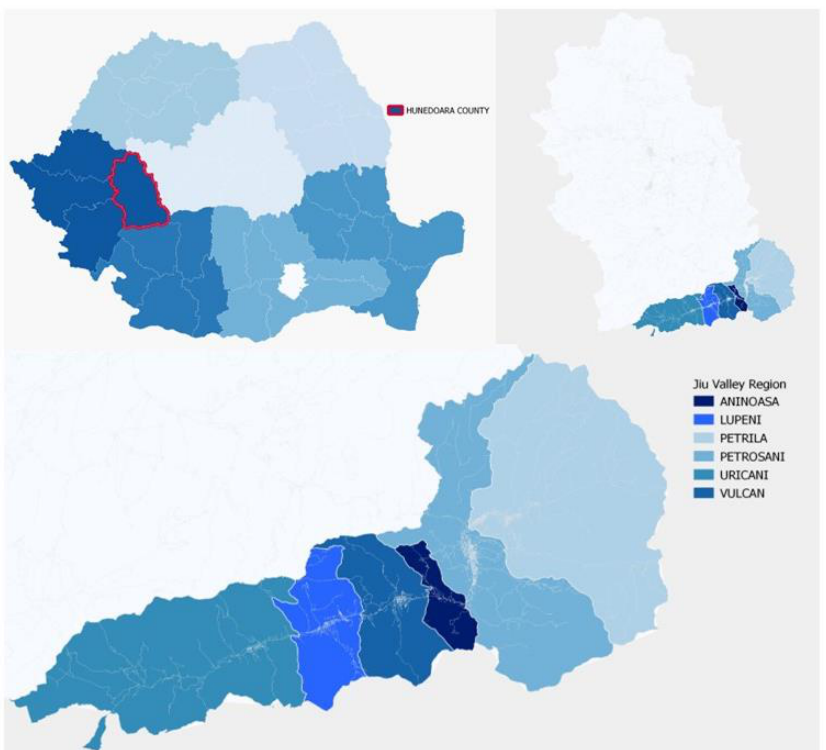
Figure 1. Geographical location of the study area in Romania and the Hunedoara County. Source: https://data.gov.ro/ (accessed on 10 May 2022).